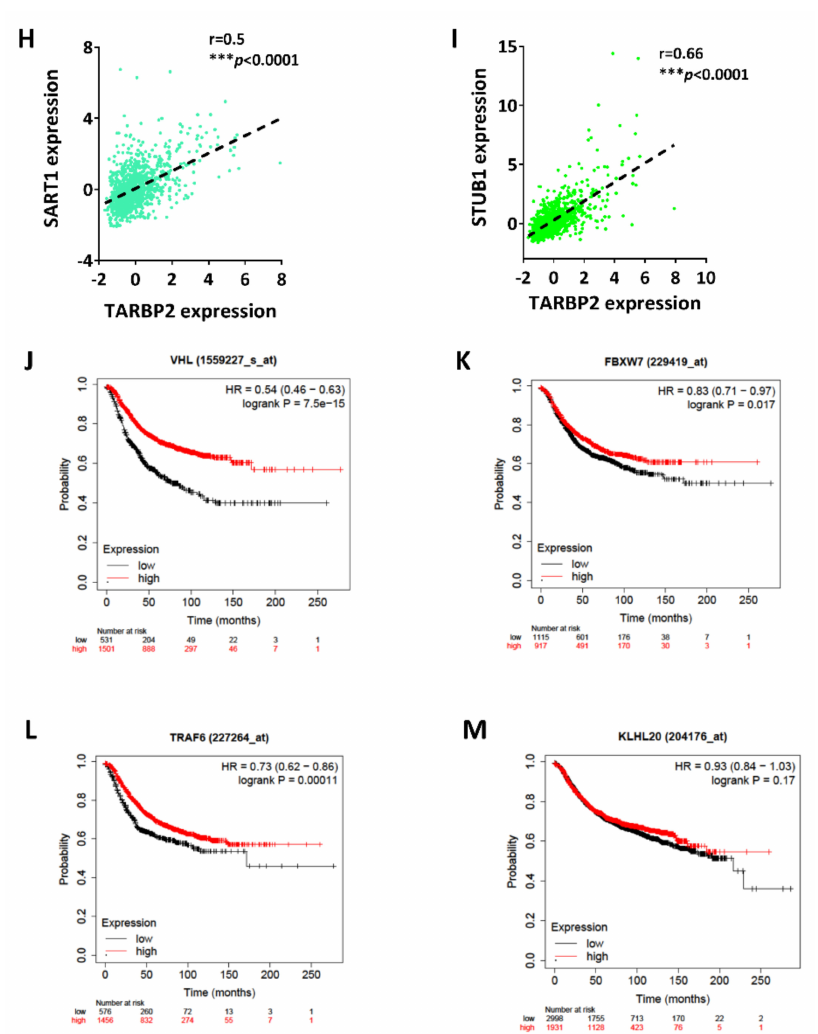
Figure 3. The effect of TARBP2 on the expression of HIF-1 α -targeting E3 ligases. ( A ) Relative mRNA expression of HIF-1 α -related E3 ligases in TARBP2-overexpressing MCF-7 cells. Correlation between TARBP2 and E3 ligases, including VHL ( B ), FBWX7 ( C ), TRAF6 ( D ), KLHL20 ( E ), SIAH1 ( F ), SPOP ( G ), SART1 ( H ), and STUB1 ( I ), using the cohort of patients with breast cancer from the TCGA database. Kaplan–Meier curves for relapse-free survival (RFS) of patients with VHL-high/low ( J ), FBWX7-high/low ( K ), TRAF6-high/low ( L ), and KLHL20-high/low ( M ) were derived. Correlation analyses were performed using Pearson’s correlation coefficient, * p < 0.05, ** p < 0.01, *** p <